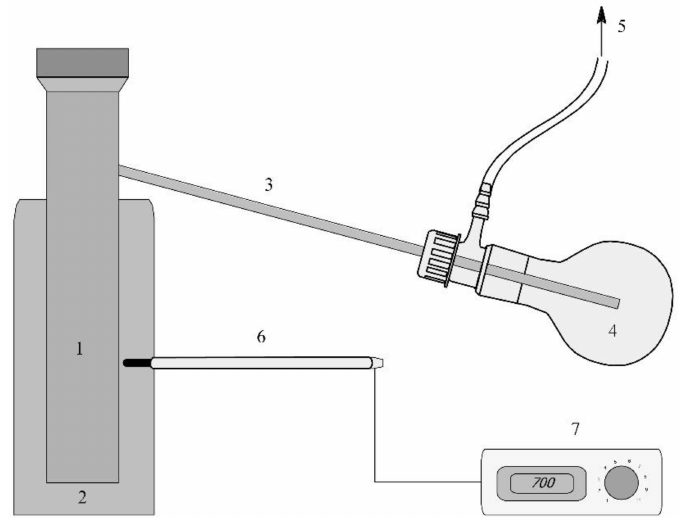
Figure 1. The apparatus used for pyrolysis of the rapeseed cake (1. pyrolysis reactor, 2. furnace. 3. air cooler, 4. condenser, 5. waste gases, 6. thermocouple, 7. temperature